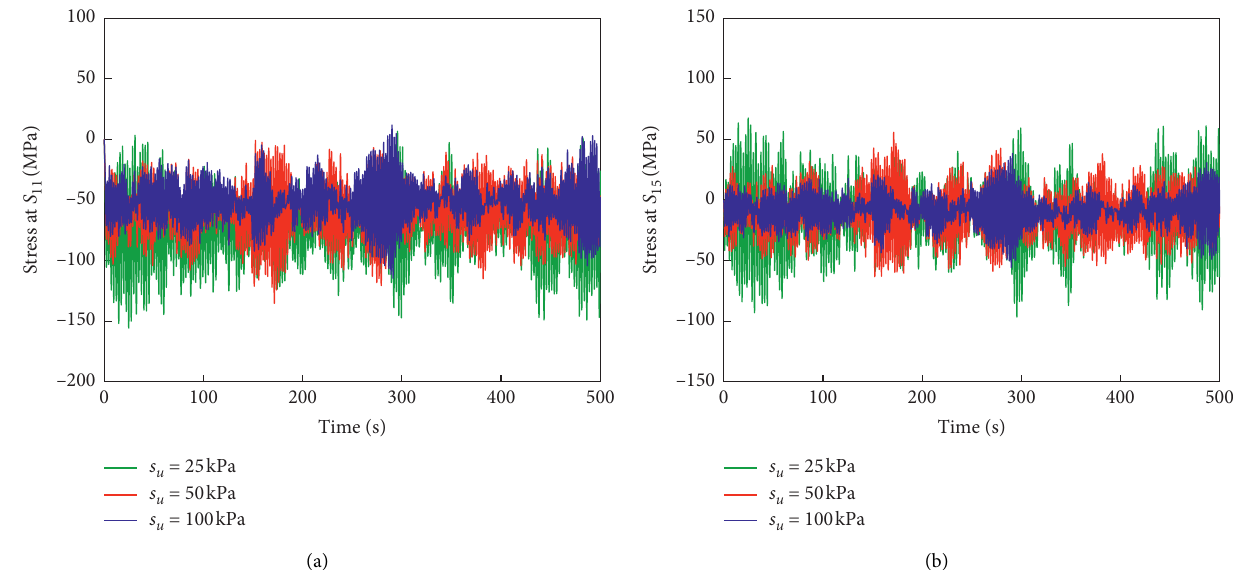
Figure 12: Comparison of stress at the pile top cross section for different soil conditions: (a) time histories of stress at S of stress at S 15 ( v � 36 cm/s, h � 8cm, σ � 1.0MPa).